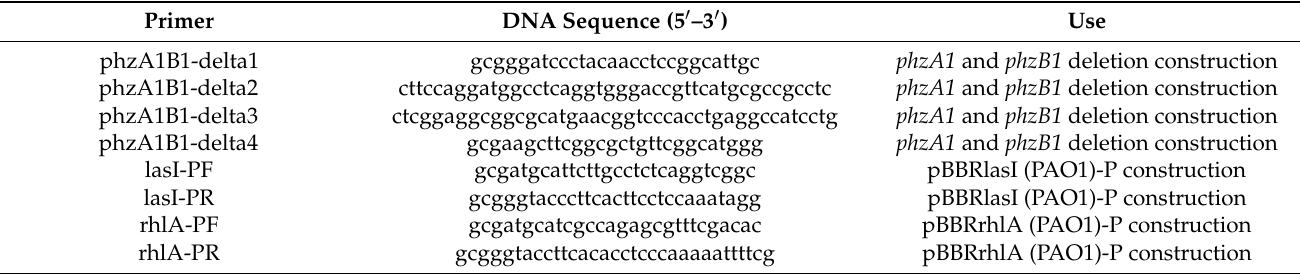
Table 1. Primers used in this